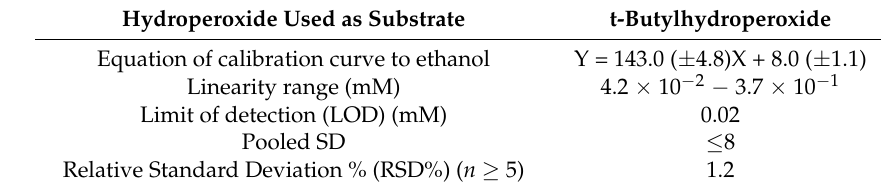
Table 1. Principal analytical data referring to the catalase organic phase enzyme electrode (OPEE) and equation of calibration straight line for ethanol, operating in decane and using t-BuOOH.